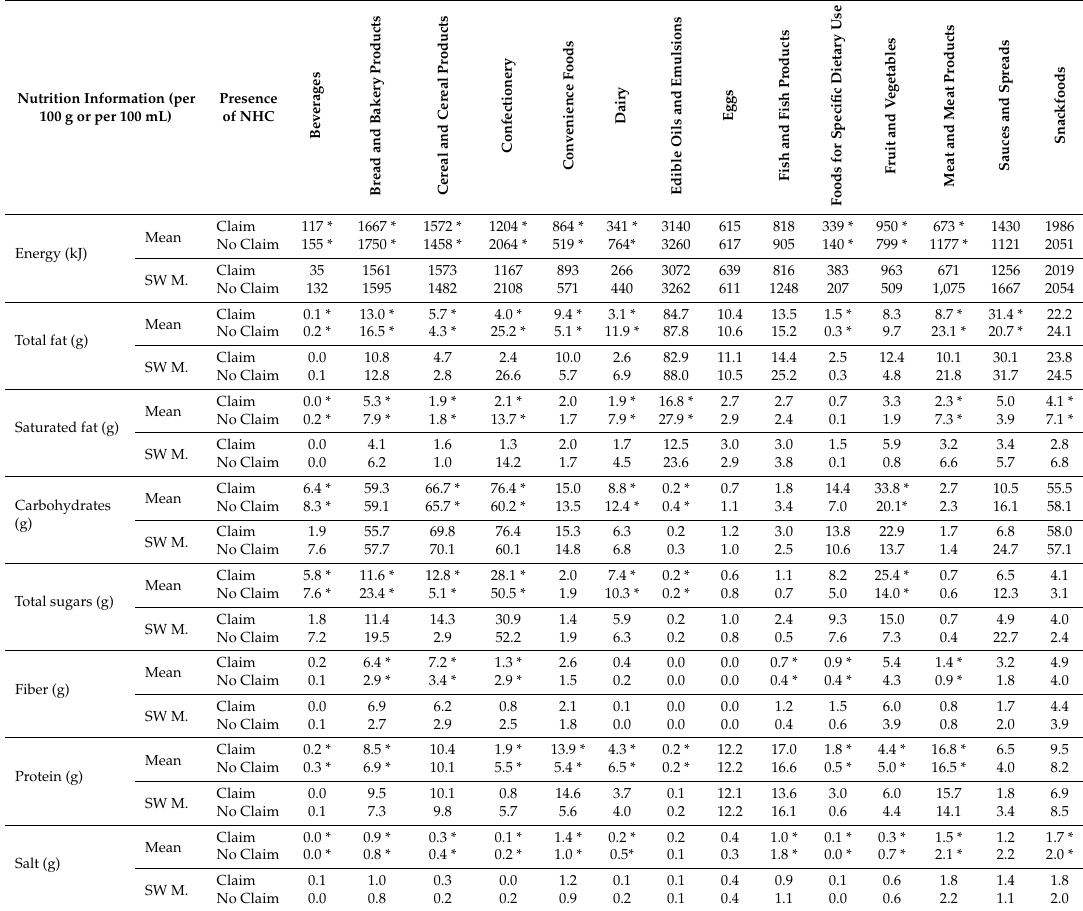
Table 3. Comparison of the nutritional composition of foods and beverages with ( n = 1708) and without ( n = 4911) claims by food categories mean and sales weighted mean (SW